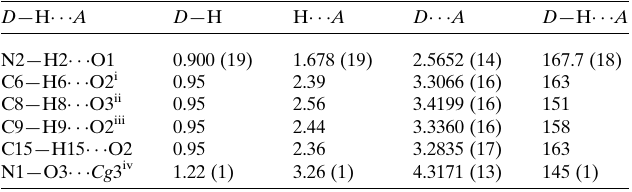
Table 2 Hydrogen-bond geometry (A˚ , (cid:4) ) for (I). Cg 3 is the centroid of the C11–C16 ring.